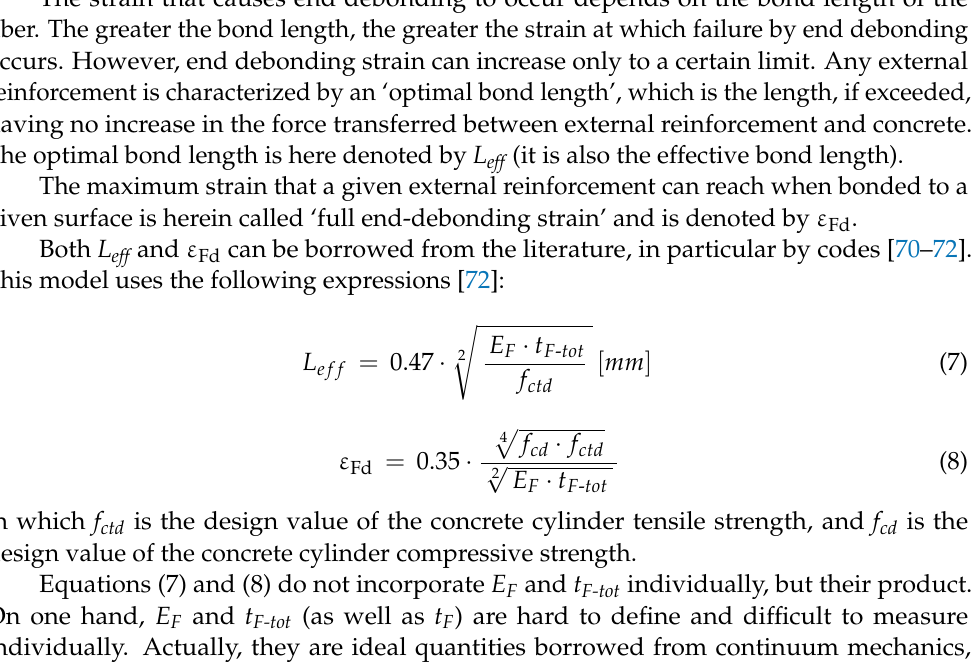
Figure 5. Fraction μ of μ’ that represents the effective height of the side-bonded fabric sheet, whereas the remaining part of μ’ is the anchorage (bond) length. The shadowed length L d + L d is the length of a fiber that crack opening causes to debond around the crack.